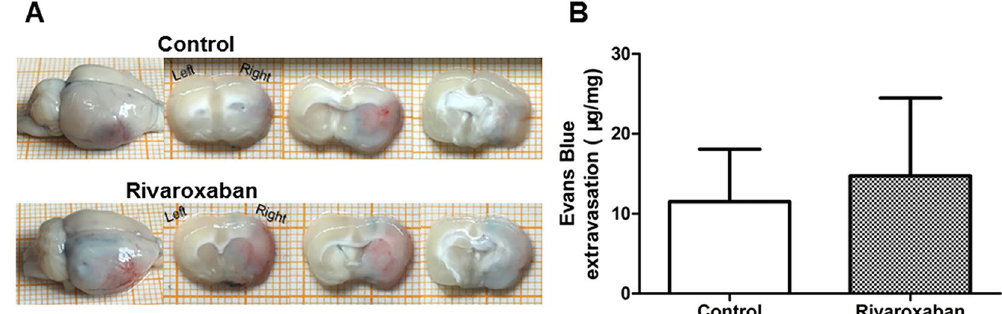
Figure 4. Effects of Rivaroxaban on BBB permeability in rats. ( A ) Topography and extent of EB extravasation in Rivaroxaban-pretreated (n = 6) and diabetic control rats (n = 6). ( B ) Bar graph depicting EB extravasation in all the groups. EB extravasation of the Control group (15.67 ± 3.36 μ g/mg) and Rivaroxaban group